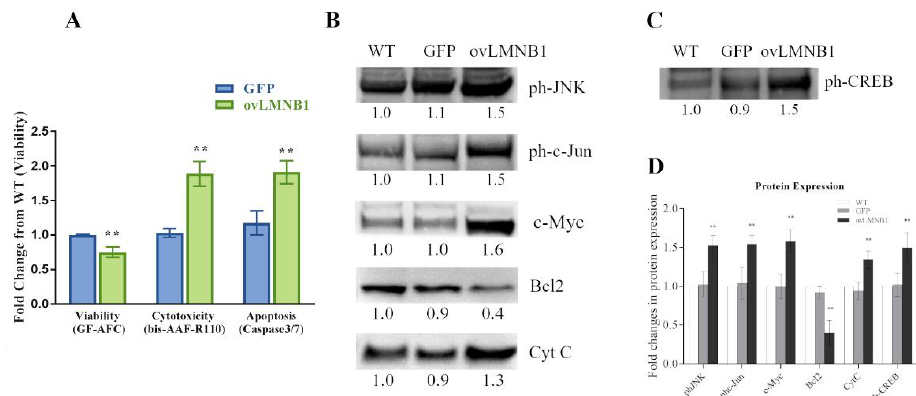
Figure 4. Lamin B1 accumulation reduces cell viability and induces apoptosis signaling pathways: ( A ): Cell viability, cytotoxicity, and apoptosis of transduced cells (ovLMNB1 and GFP) were evaluated by using the ApoTox-Glo Triplex Assay and compared to wild type cells. Analyses from three independent experiments, with ** p < 0.01 vs. corresponding mock-transduced sample (GFP). ( B ): The activation of signaling pathways involved in apoptosis and the expression of downstream targets was evaluated in U87-MG cells 96 h after transduction. The expression or the phosphorylation of the denoted proteins were evaluated. ( C ): CREB phosphorylation was measured in wild type, mock-transduced, and Lamin B1–overexpressing cells. Samples were normalized by using total protein normalization vs. wild type cells. Results are representative of five independent experiments. ( D ): Quantitative analysis of protein expression; wild type cells (WT) were used as reference sample. ** denotes p < 0.01 vs. corresponding mock-transduced sample (GFP).